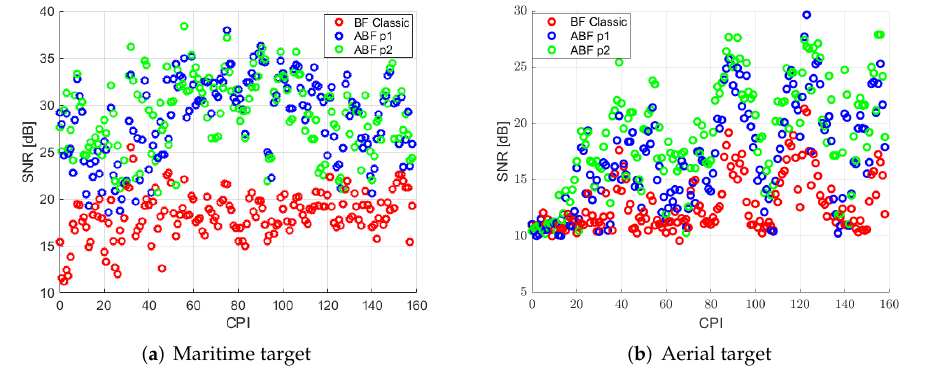
Figure 14. SNR of selected targets in each CPI for classical beamforming and ABF